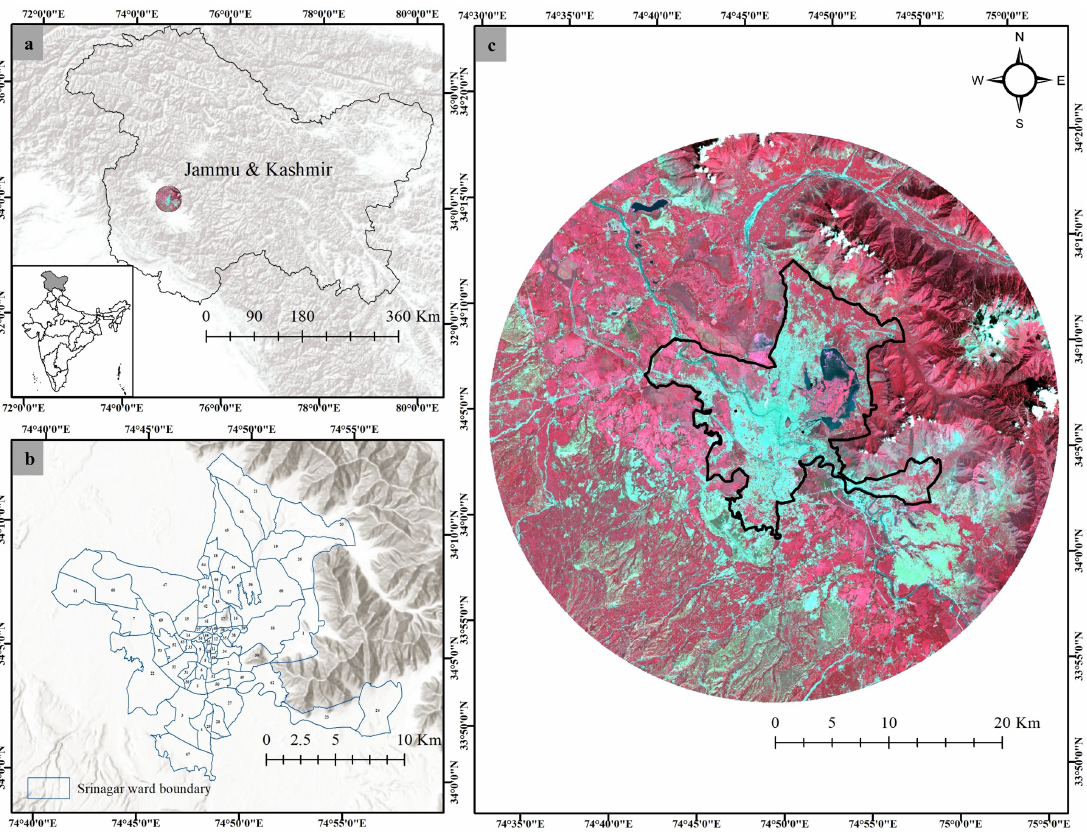
Figure 1. Location of the study area Srinagar, India: ( a ) geographical location of study area in Jammu and Kashmir; ( b ) administrative wards of Srinagar city (see supplementary Table S1 for ward names); ( c ) satellite image of the study